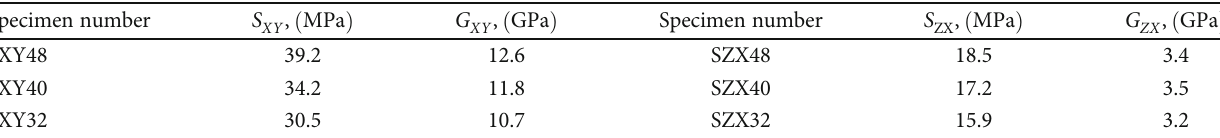
Figure 11: Shear test results. Table 6: Shear mechanical properties of axial braided C/C